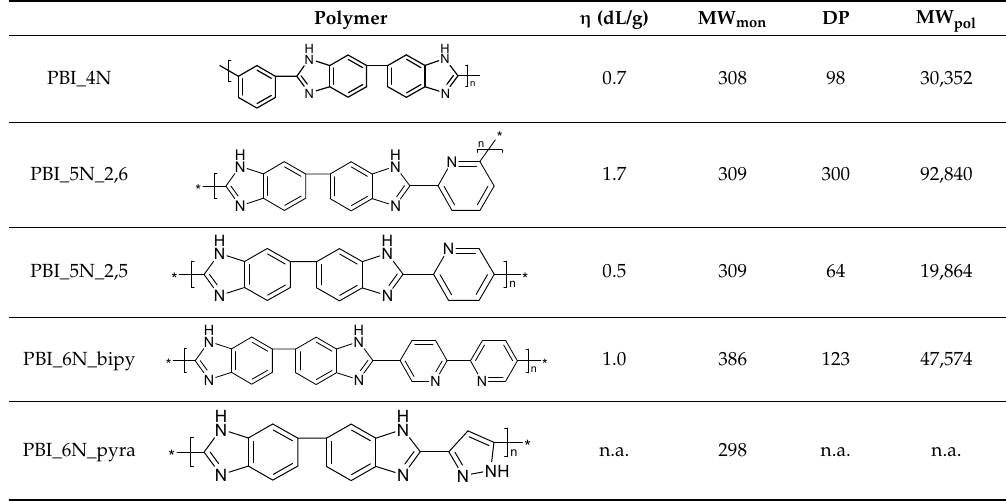
Table 1. Polymers names: PBI_4N : Poly-2,2 ′ -(m-phenilene)-5,5 ′ -bibenzimidazole. PBI_5N_2,5 : Poly-2,2 ′ -(2,5-pyridine)-5,5 ′ -bibenzimidazole. PBI_5N_2,6 : Poly-2,2 ′ -(2,6-pyridine)-5,5 ′ -bibenzimidazole. PBI_6N_bipy : Poly-2,2 ′ -(2,2 ′ -bipyridine-5,5 ′ )-5,5 ′ -bibenzimidazole). PBI_6N_pyra : Poly-2,2 ′ -(3,5-pyrazole)- 5,5 ′ -bibenzimidazole. η : intrinsic viscosity. MW mon : monomer molecular weight. DP : degree of polymerization. MW pol : polymer molecular weight.